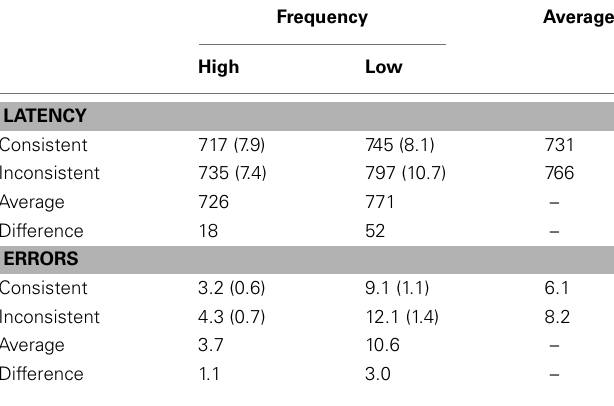
Table 3 | Mean latencies (in milliseconds) and percentages of errors for an orthogonal manipulation of consistency and frequency in the auditory lexical decision task of Experiment 1 (SEs are into